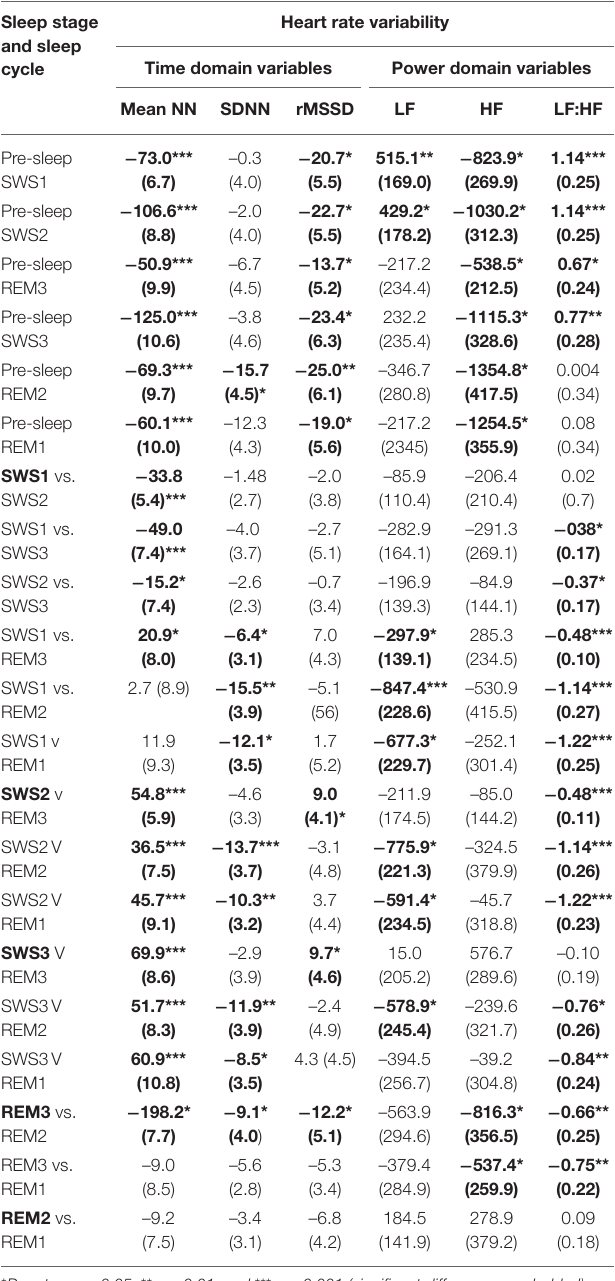
TABLE 4 | Mean (Standard Error) differences between heart rate variability values according to sleep stage and sleep cycle. Sleep stage and